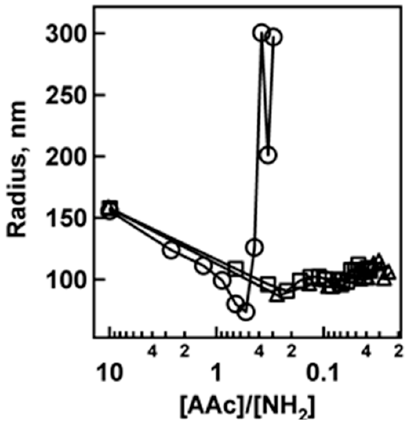
Figure 2 . Nanogel titration plots for the titration of 10% BIS, 10% AAc nanogels upon the addition of 0.5 ( ), 2.0 ( ), and 5.0 ( ) μ L PAH aliquots. The hydrodynamic radius of nanogels measured by DLS.